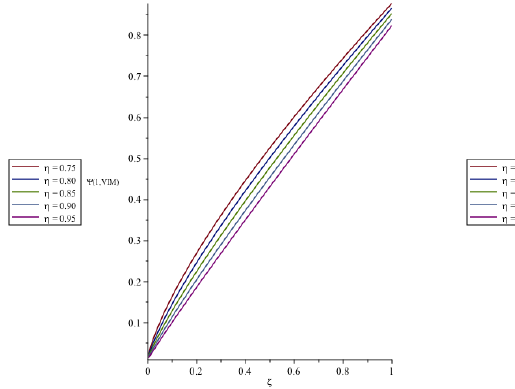
Figure 7. Plot of the first-level approximate solution ψ 1 ( χ , ζ ) at χ = 0.1 for different values of η when ¯ h = − 1 for Example